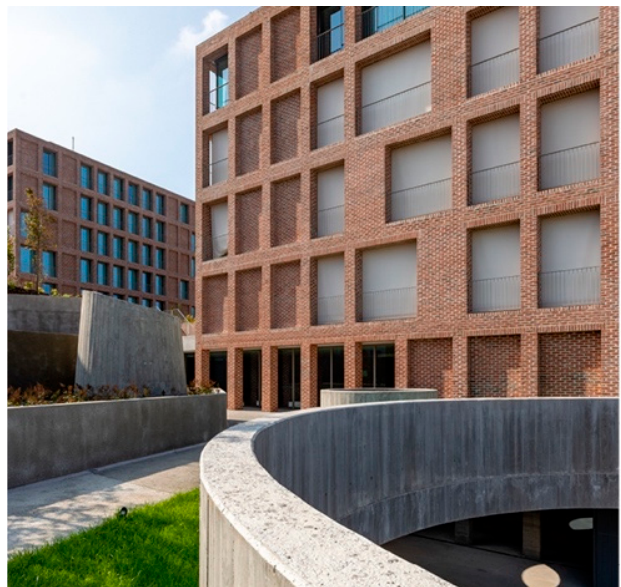
Figure 17. Coimbra. Old factory. ©João Ferrand.